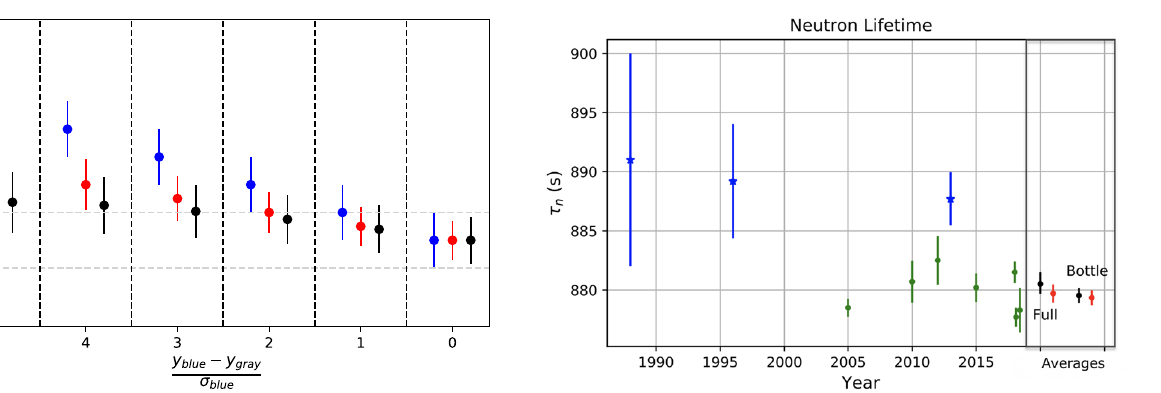
Fig. 7 The measurement points with small error are shown in blue, the usual averages with the PDG scaling in red, and the hierarchical averages in black. The labels at the horizontal axis show by how many σ M thebluepointsdeviatefromthegraypoint.Thegraybandrepresents the ordinary weighted averages of the bulk of measurements in Fig. 6